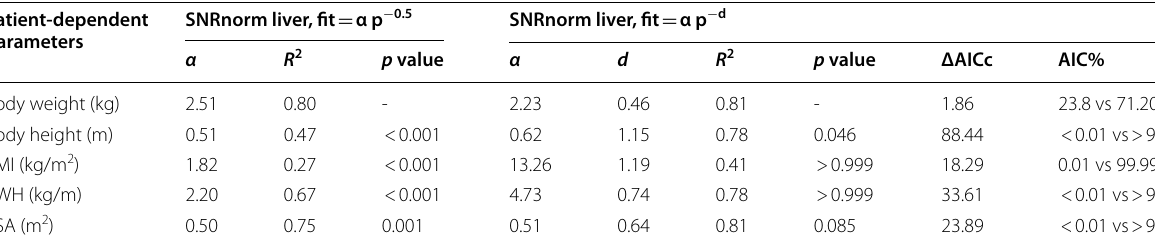
Table 2 Fits of SNRnorm liver with the patient-dependent parameters Patient‑dependent